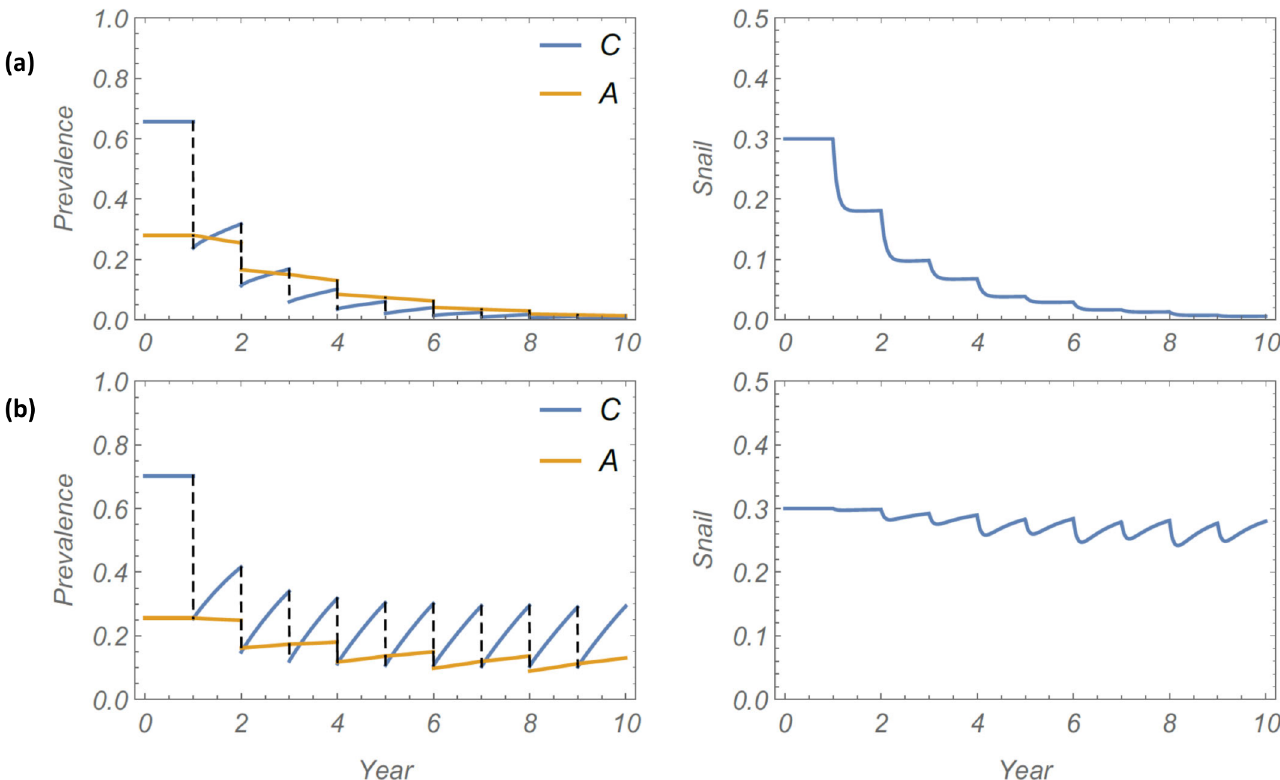
Fig 2. Projected 10 year MDA history for the calibrated high-risk model community, with either linear (Panel a) or non-linear/saturable FOI (Panel b). The simulated MDA program attained 75% coverage for children (annually), and 35% coverage of adults (biennially). The left side graphs indicate simulated S . haematobium infection prevalence over time among children (C) and adults (A); the right side graphs indicate simulated pre-patent + patent infection prevalence among local Bulinus snails.